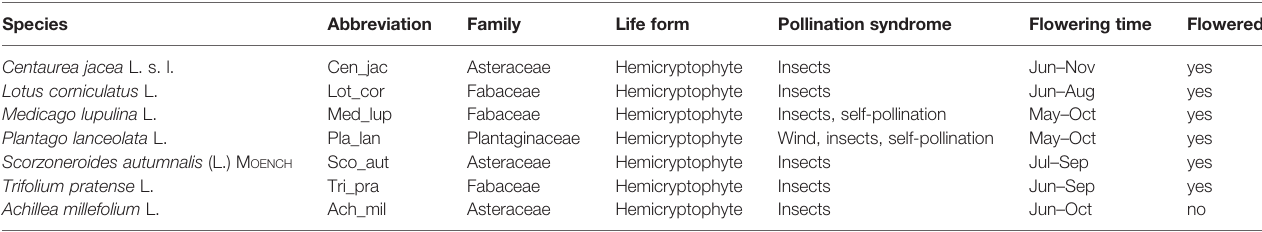
TABLE 1 | Overview of observed plant species with corresponding abbreviation, family, life from, pollination syndrome, fl owering time, and the information whether the species fl owered during the experiment.